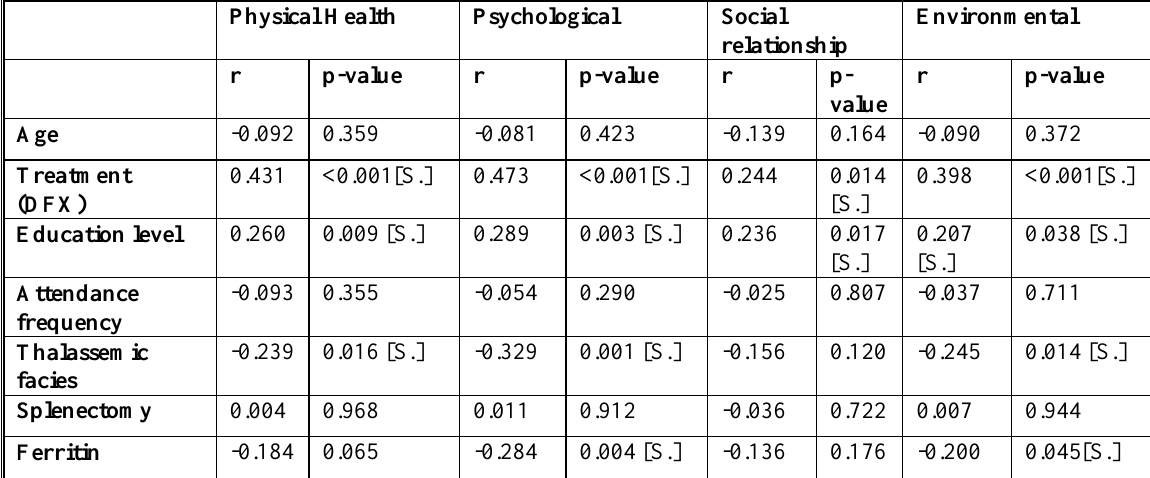
Table (5) Predictors of QoL in adult